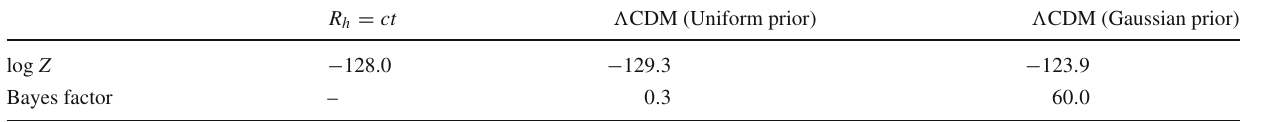
Table 3 Comparison of Bayes factor for R h = ct and (cid:2) CDM using unbinned measurements of chronometer data listed in Table 1, using two different sets of priors in (cid:2) CDM (cf. Table 2) log Z denotes the logarithm of the Bayesian evidence. The Bayes factor is defined as the ratio of the evidence of the (cid:2) CDM model to the evidence for the